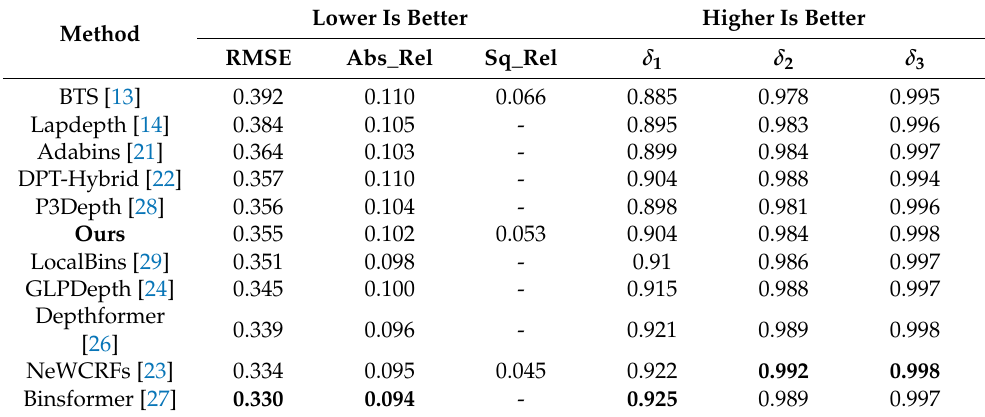
Table 5. Performance comparison using the NYU Depth v2 Dataset with state-of-the-art